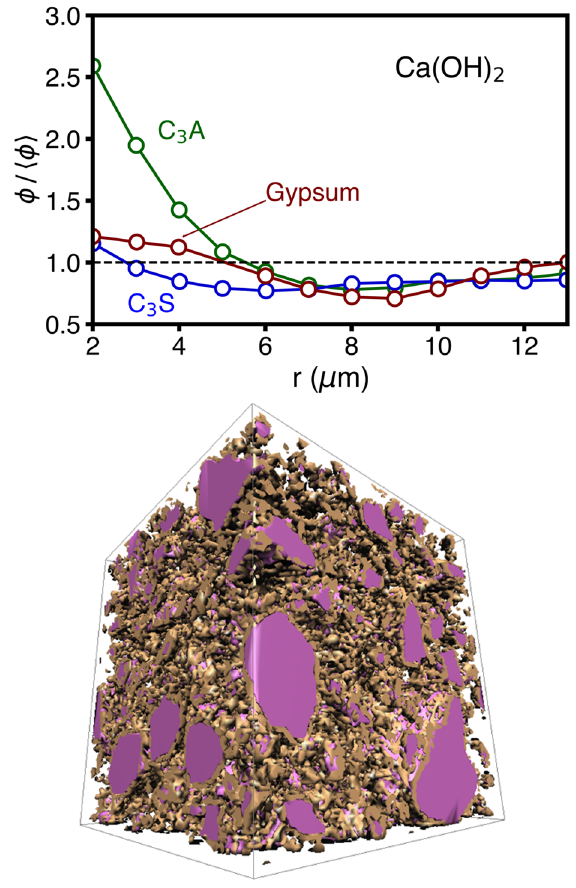
Figure 2. Radial distribution of concentration of CH normalised to its average concentration from the surface of various phases (top); kinetic cellular automaton simulation of the precipitation of CH in solution demonstrating the influence of non ‐ uniform concentrations (bottom). The algorithm details and assumptions of the model producing these simulation results are provided fully in Ref. [28].